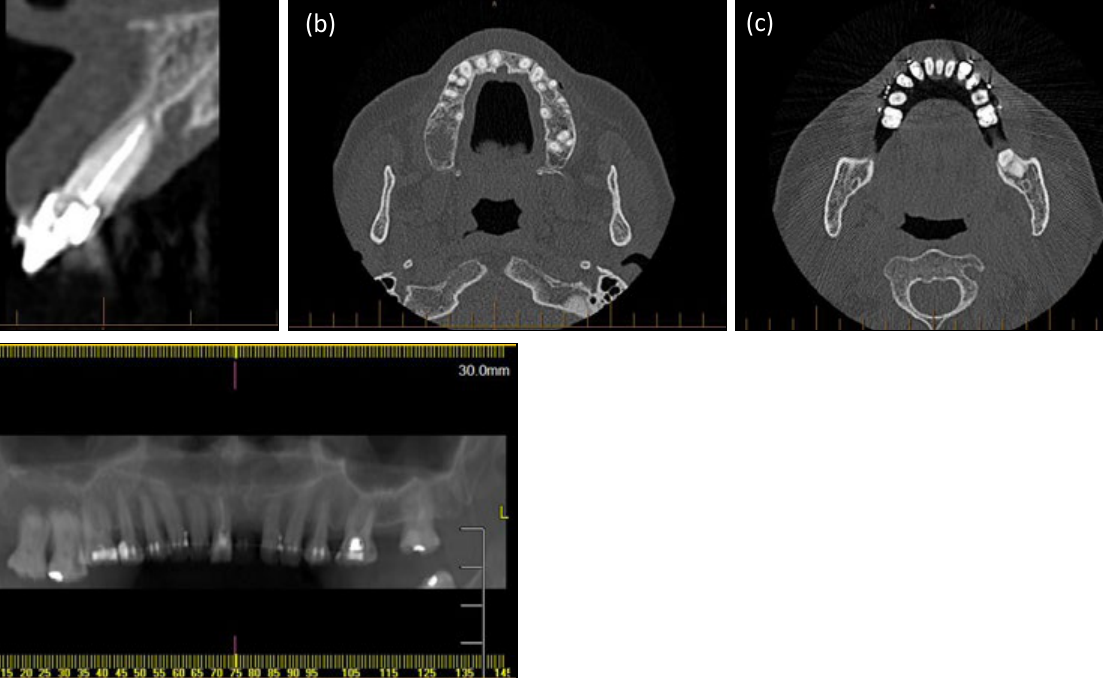
Figure 10. Pre-implant 3D CT scan. (a) Satisfactory angulation of the 11 within the alveolar ridge. (b) Upper teeth remain within the anatomical limits of the alveolar bone. (c) Lower teeth remain within the anatomical limits of the alveolar bone. (d) Reconstructed panoramic film reveals appropriate root parallelism for the planned restorative implant in the 21 edentulous